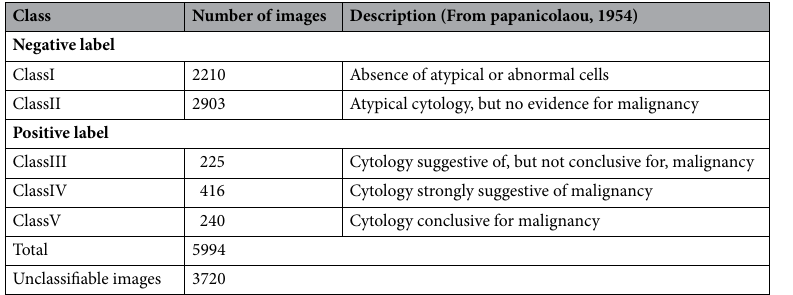
Table 3. Label data distribution.